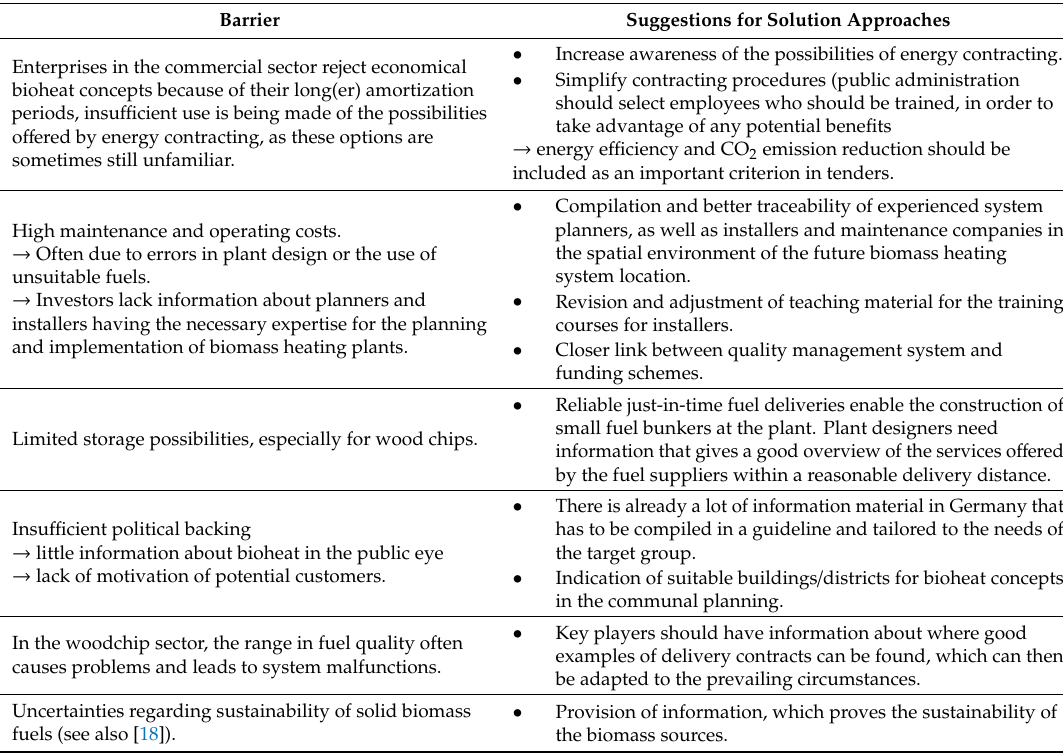
Table 3. Deficits in knowledge and approaches to further expand of bioheat concepts (partly cited and revised from [42]).